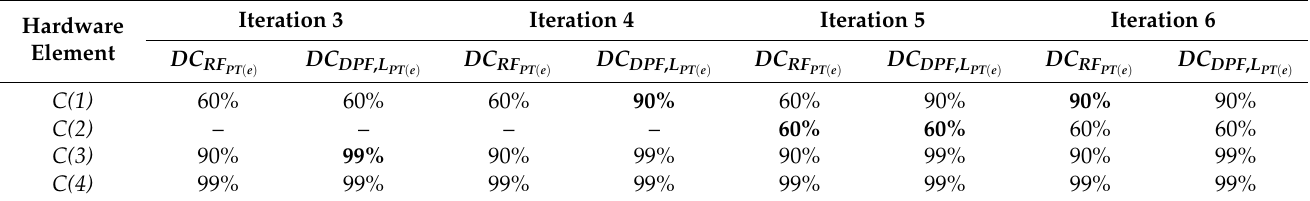
Table 8. The assigned DC RF in each design iteration is marked as bold